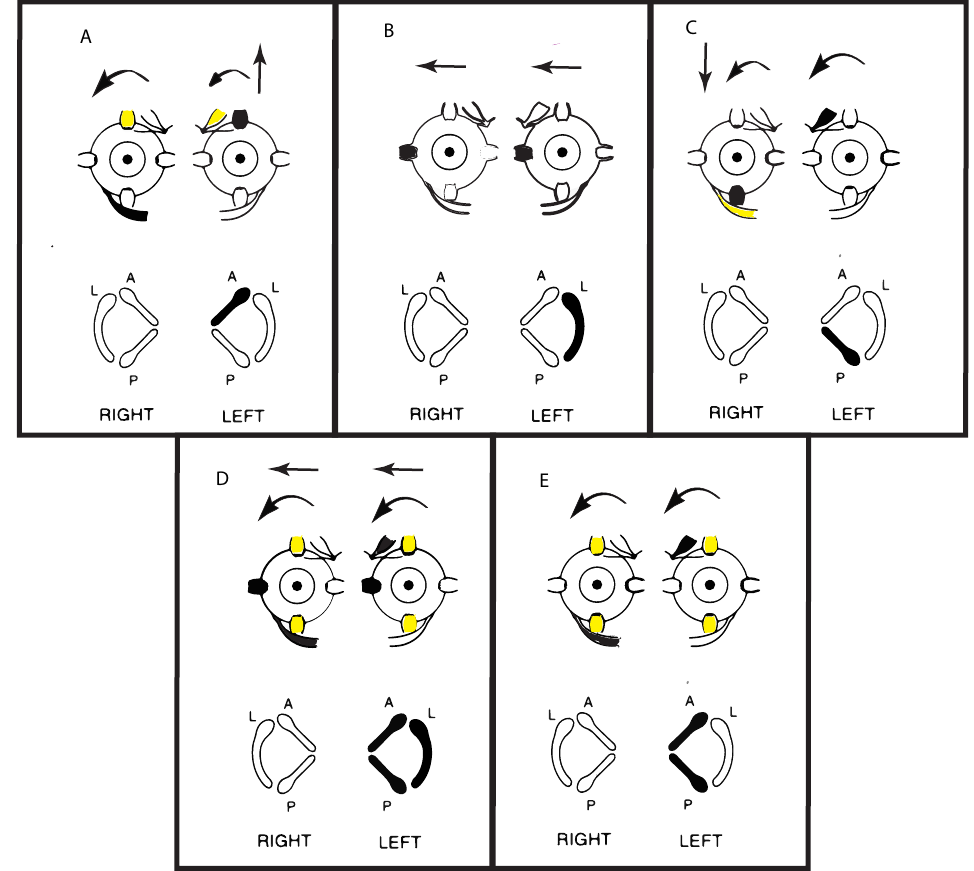
Figure 4. Representations of the direction of eye movements in response to selective electrical stimu- lation of individual canals (from Cohen, Suzuki, Bender 1964). The point of view of the semicircular canals in the schematic is straight down on the labyrinths. The arrows in these figures show the direction of the slow-phase eye velocity of the eye movement response to electrical stimulation of individual canals. The stimulated canal(s) are shown in black and the main eye muscles generating the eye movement (arrows) are shown as black. The muscles providing a smaller contribution are shown as yellow. ( A – C ) show the slow phase eye movements induced by stimulation of individual canals. Note that the movements in ( A , C ) are disconjugate, while those in ( B ) are conjugate horizontal eye movements away from the stimulated side. ( E ) shows the effect of simultaneous stimulation of both vertical canals in a labyrinth—generating torsion away from the stimulated ear, with minimal vertical or horizontal components. Simultaneous stimulation of all canals in a labyrinth ( D ) causes horizontal and torsional eye movements, with minimal vertical components. Reproduced from [5] with permission of